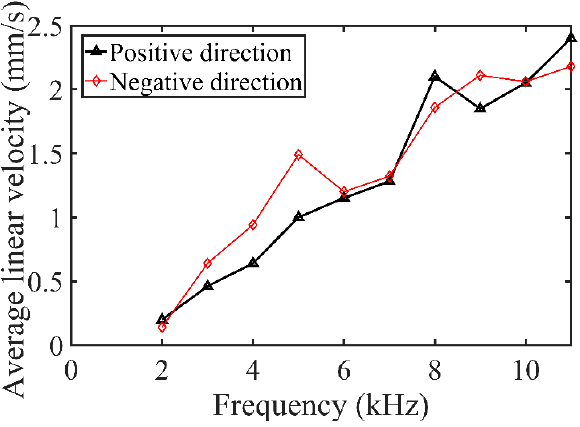
Figure 10. The linear velocities of the prototype motor under different driving frequencies.